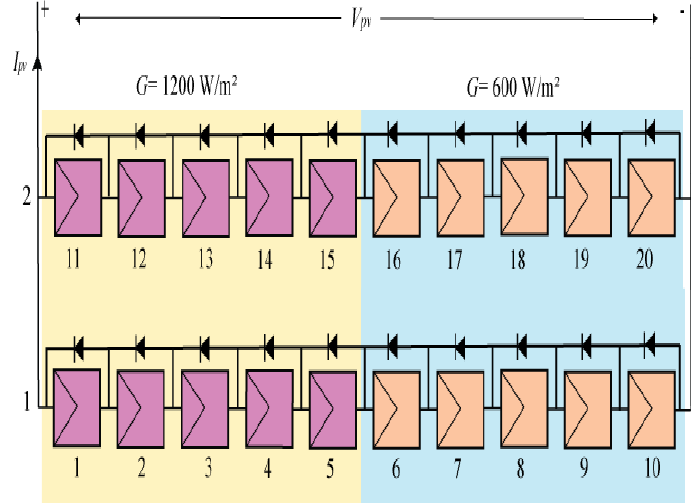
Figure 17. Shading patterns for scenario three. Energies 2022 , 15 , x FOR PEER REVIEW